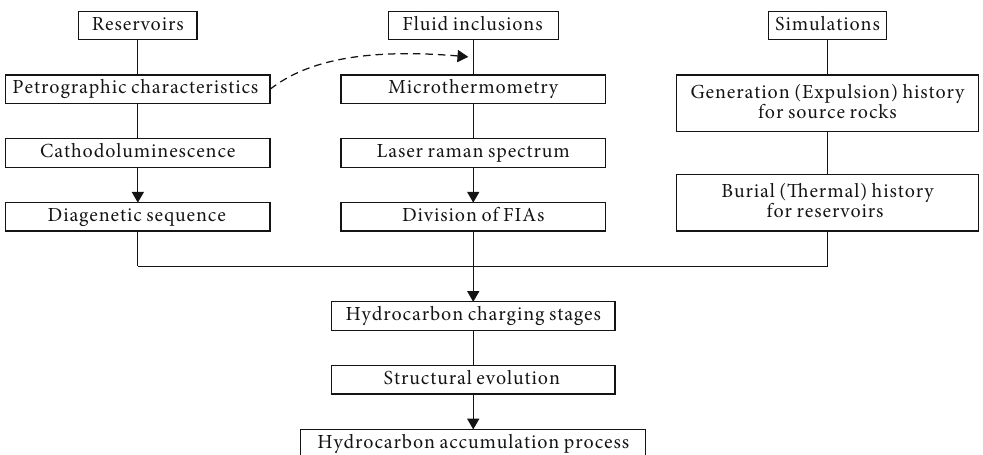
Figure 1: Speci fi c research ideas on the hydrocarbon accumulation process of the ADRRB. The dashed line in the fi gure indicates that petrographic observation is also required when dividing FIAs. Fluid inclusion assemblage (FIA) is de fi ned as all inclusions along the same growth zone in a single crystal or all inclusions along a single healed fracture, usually present in clusters or in a consistent extension direction